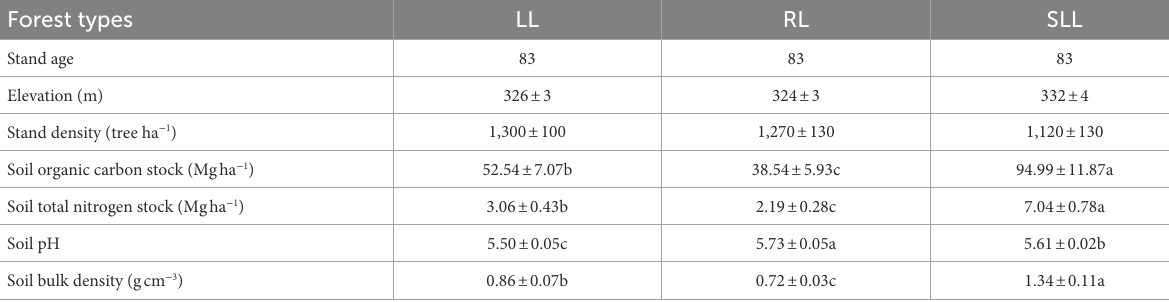
TABLE 1 Stand characteristics of three types of larch forest. Forest